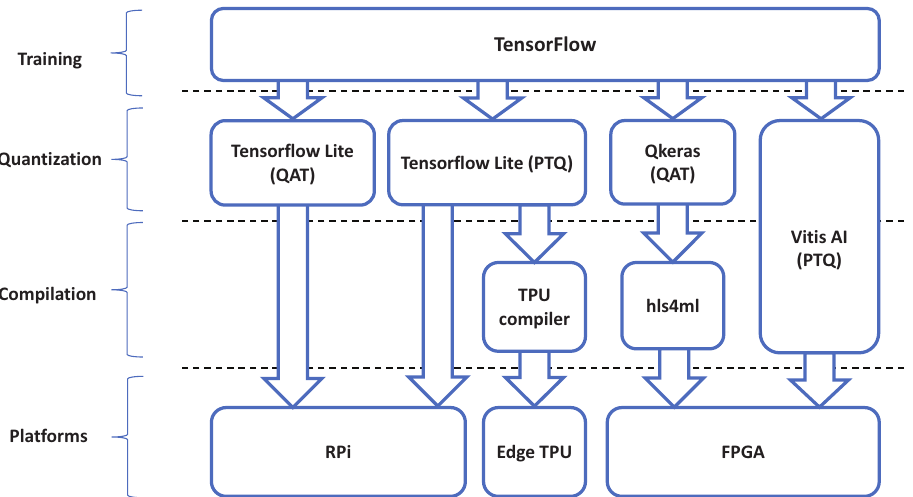
Figure 1. Tool flows for embedding a CNN on different embedded devices. Tensorflow, the general framework for training CNNs, is at the top. Going down, the tools for converting the floating point models to fixed point models (Post-Training Quantization or Qantized Aware Training) is below this. Under that, for certain platforms, the tools for compiling the quantized models depending on the specific platform. At the bottom, the embedded platforms are displayed. Notice that Vitis AI performs both quantization and